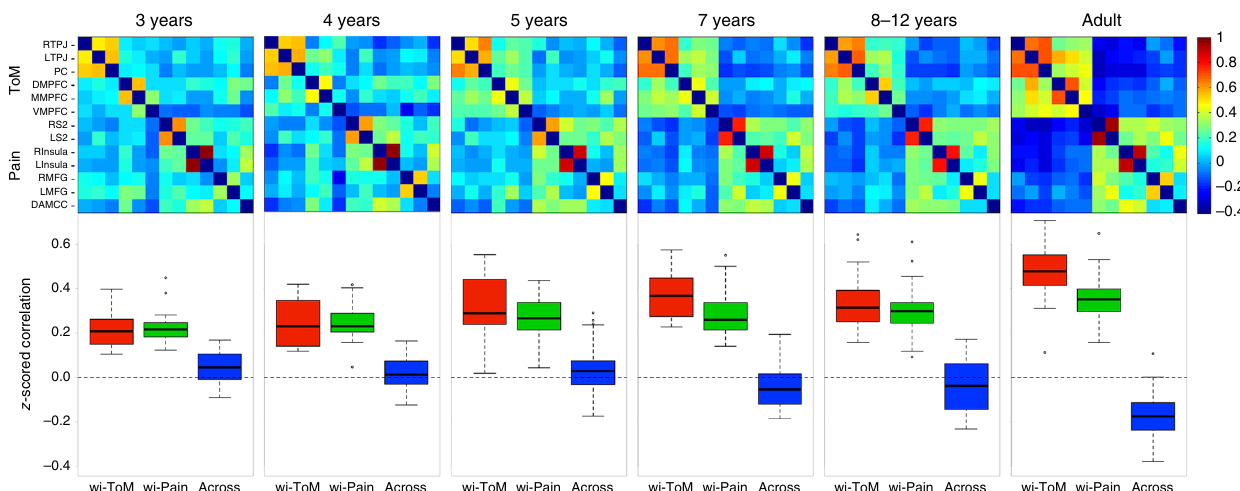
Fig. 2 Inter-region correlation analysis. Top row: Average z -scored correlation matrices across all ToM and pain brain regions of interest (see Y -axis) per age group (3yo: n = 17; 4yo: n = 14; 5yo: n = 34; 7yo: n = 23; 8 – 12yo: n = 34; adults: n = 33). Regions are in the same order along the X -axes and Y -axes. Bottom row: boxplots of the within-ToM (red), within-Pain (green), and across-network (blue) z -scored correlation values per age group. Note that while data are binned into age groups here, age is a continuous variable in statistical